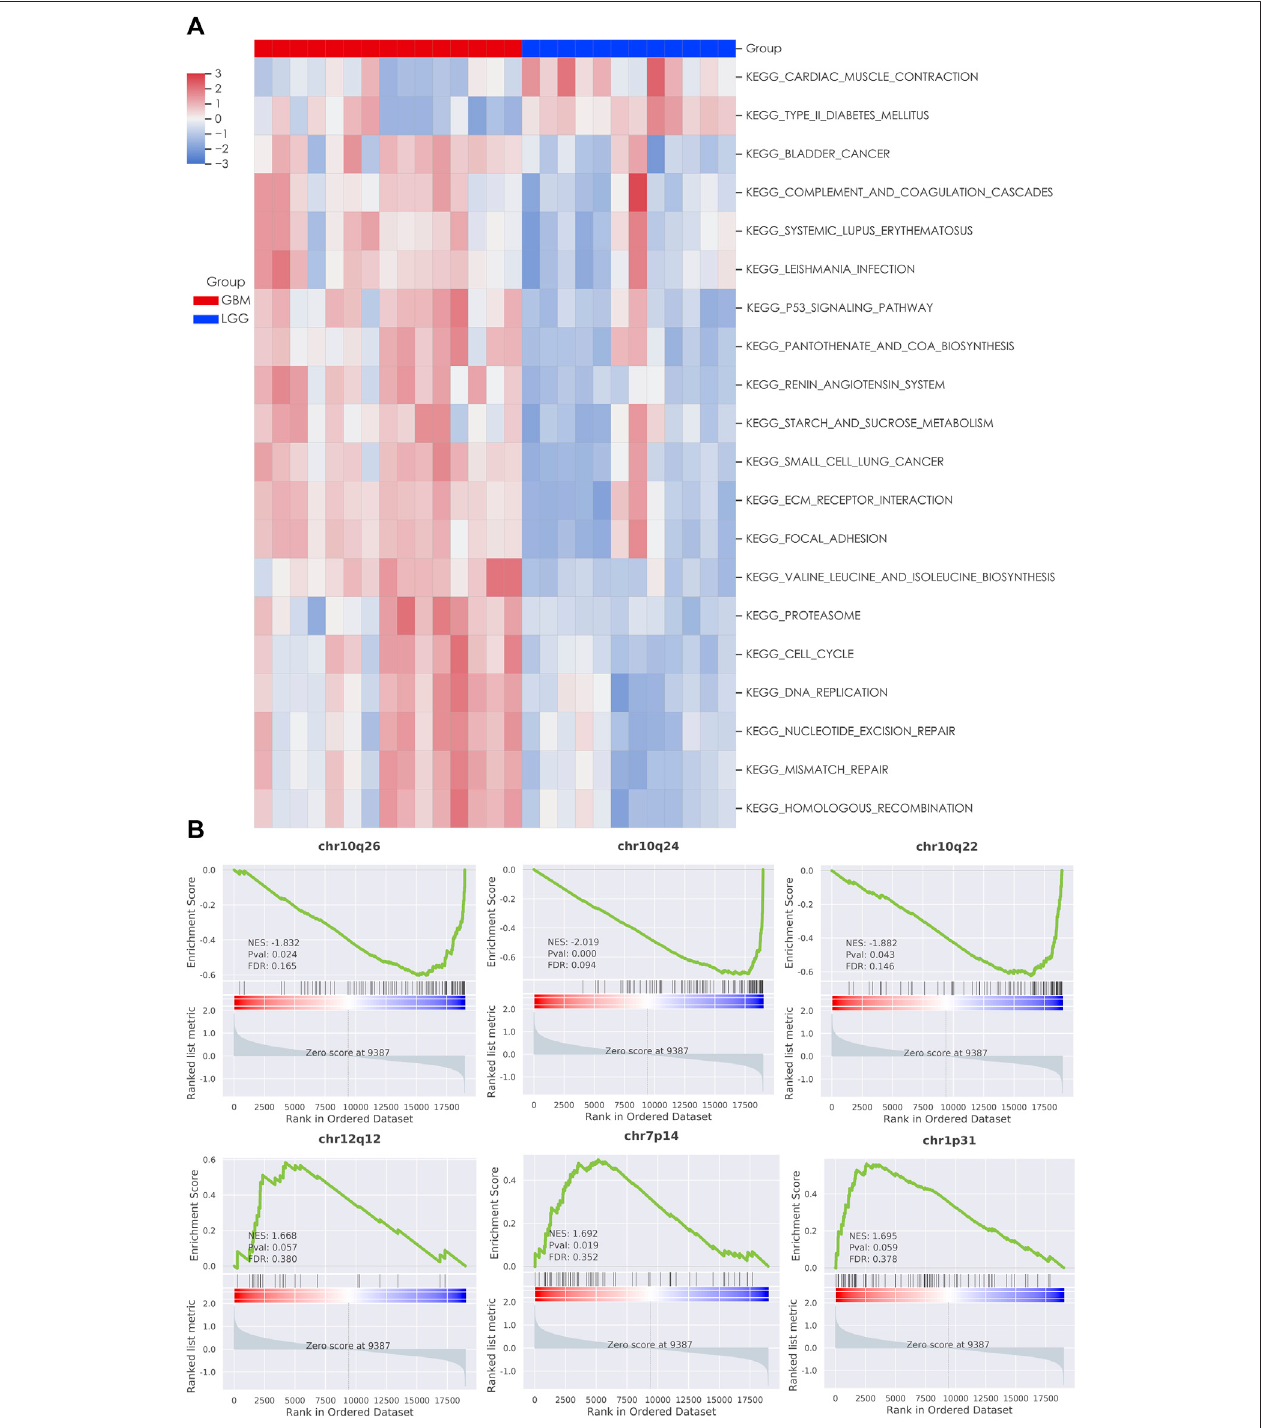
FIGURE 2| Gene set enrichment analysis (GSEA) ofLGG and GBM transcriptomes. (A) Heatmap ofsigni fi cantKEGG pathways in patients; (B) enrichmentplot of chromosomal locations with the most signi fi cant EnrichmentScores (ES).